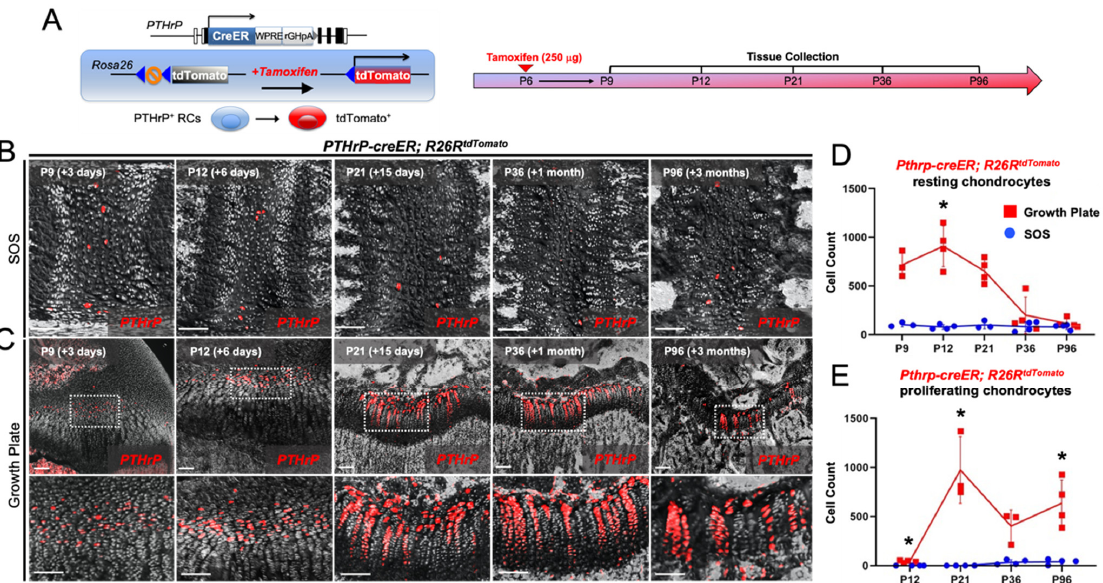
Figure 3. PTHrP + chondrocytes lack column-forming capabilities in the cranial base synchondrosis. ( A ) Diagram of Pthpr-creER; R26R-tdTomato lineage-tracing model (Left) and tissue collection time points (Right). ( B , C ) Cell-lineage analysis of Pthrp-creER; R26RtdTomato + (tamoxifen at P6) chondrocytes in the cranial base synchondrosis ( B ) and the femoral growth plate ( C ) following 3 (P9), 6 (P12), and 15 days (P21) and 1 month (P36) and 3 months (P96) of the chase. ( C , Upper panels) Overview of femoral growth plate. ( C , Lower panels) 40× magnified views of Pthrp-creER; R26R-tdTomato + chondrocytes in the resting zone of the femur growth plate. Red: tdTomato, gray: DIC. Scale bars: 100 μ m. ( D ) Quantification of Pthrp-creER; R26R-tdTomato + resting chondrocytes. ( E ) Quantification of Pthrp-creER; R26R-tdTomato + proliferating chondrocytes. n = 3/4 of each group/timepoint. * p < 0.05, one-way ANOVA followed by the Mann–Whitney U test. All data